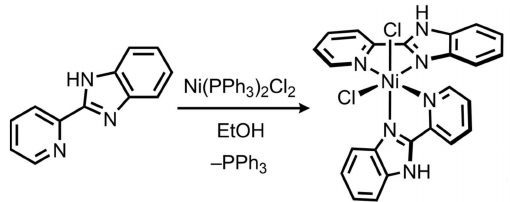
Figure 5 Reaction scheme for the synthesis of the title